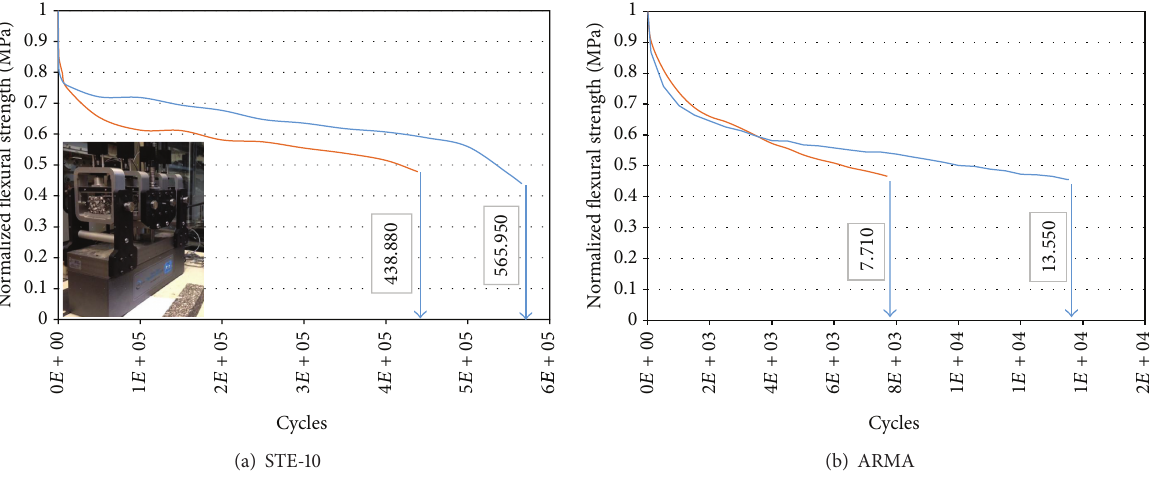
Figure 6: Beam fatigue